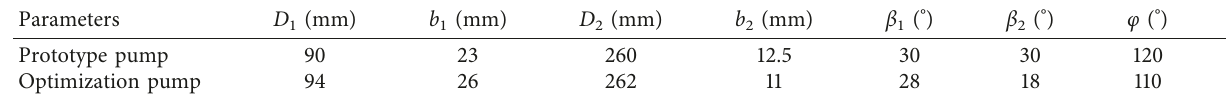
Table 4: Impeller parameter optimization results.